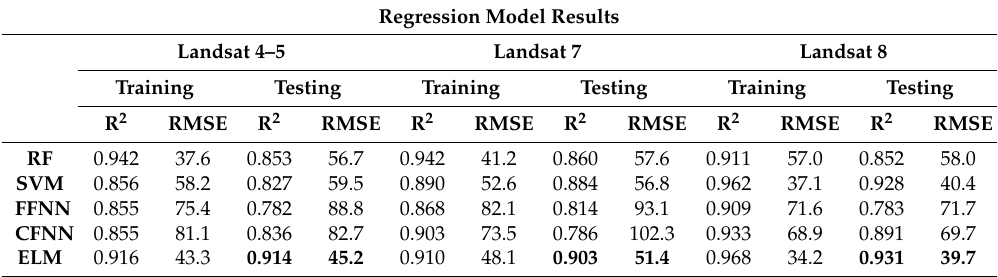
Table 4. Results of the regression modeling between the Landsat spectral information and measured SSC. Highlighted in bold are the best results for each sensor when applied to testing data.